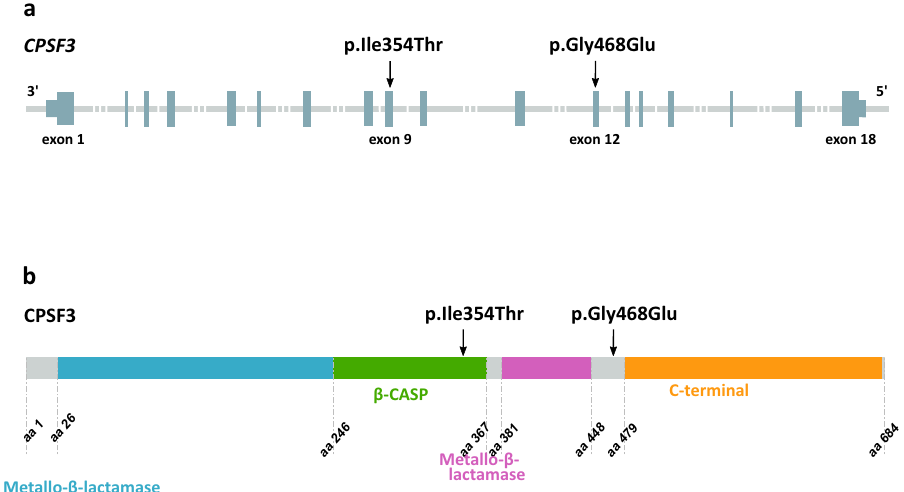
Fig. 1 Structure of CPSF3 (RefSeq transcript NM_016207.3) and location of the two missense variants found in homozygous state in patients with a severe intellectual disability syndrome. a The p.Ile354Thr and p.Gly468Glu variants are located in exon 9 and 12 of CPSF3 , respectively. Dark gray sections represent exons and untranslated regions, light gray lines represent introns. b The p.Ile354Thr variant is in the β -CASP domain of CPSF3 (amino acids 246 – 367, shown in green). The p.Gly468Glu variant is located within an uncharacterized linker domain (amino acids 448 – 479) between the critical second metallo- β -lactamase domain (shown in pink) and the highly conserved C-terminal domain (amino acids 479 – 682, shown in yellow) of CPSF3. The fi rst metallo- β -lactamase domain is shown in blue, uncharacterized domains are shown in